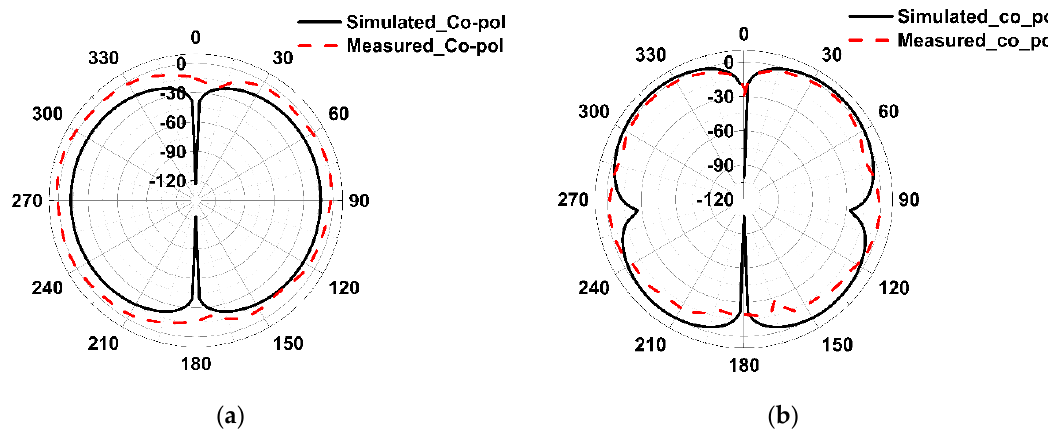
Figure 18. The radiation patterns in the XZ-plane. ( a ) 3.532 GHz; ( b ) 6.835 GHz.